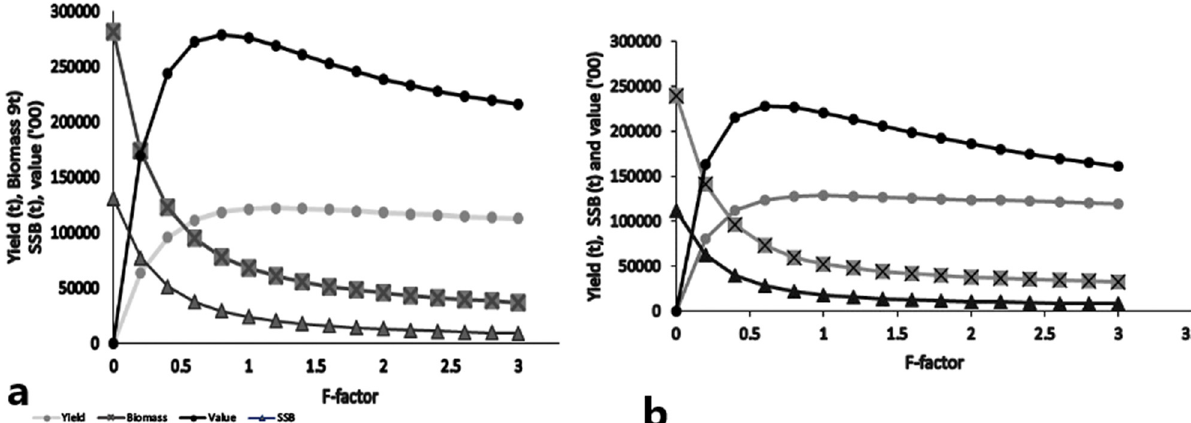
Fig. 7. Thomson and Bell analysis of yield/recruit for (a) female, and (b) male P. stylifera